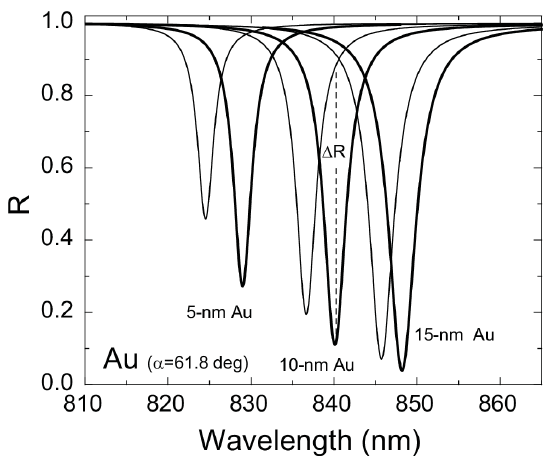
Figure 2. Shifts of the SWR peak in reflection spectra of PPhC-based sensors comprising an Au layer with thicknesses from D = 5 nm, 10 nm and 15 nm (from left to right): thin lines ( n = 1.33) and thick lines ( n + ∆ n = 1.331). Spectra are calculated for α =